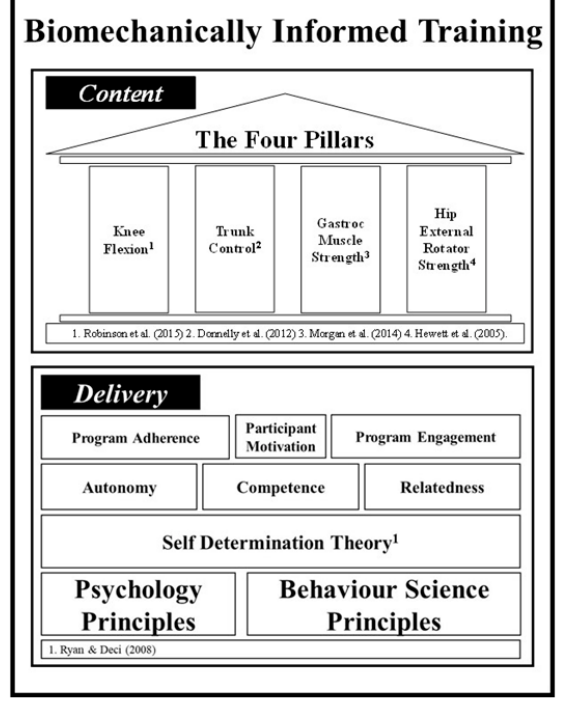
Figure 1. Theoretical overview of biomechanically-informed training (BIT). The empirical evidence for the training content above and the psychological and behavior change foundation for the delivery methods